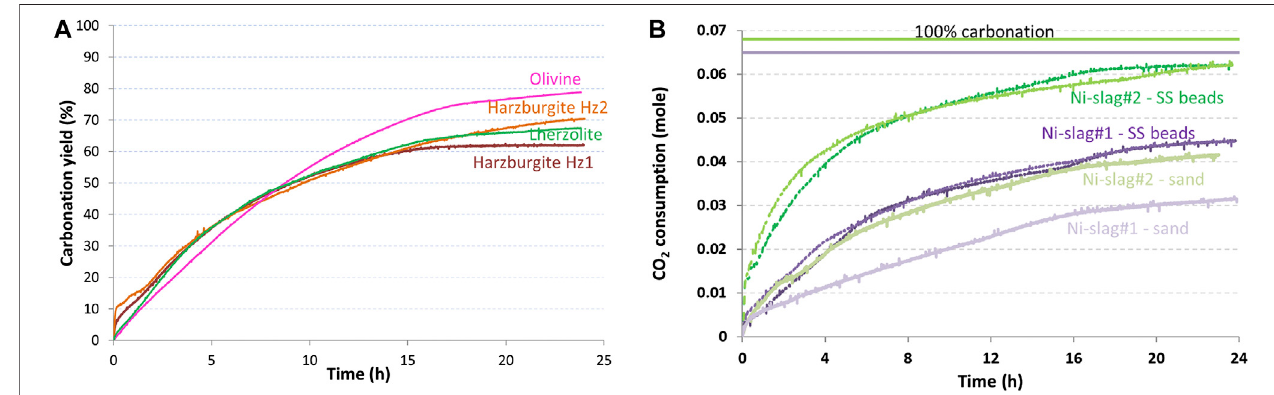
FIGURE 2 | Extent of carbonation of different materials (at 180 ° C, 20 bar of CO 2 and 90 g/L water ) during the hybrid carbonation process: (A) ores (using 1 – 2 mm Al